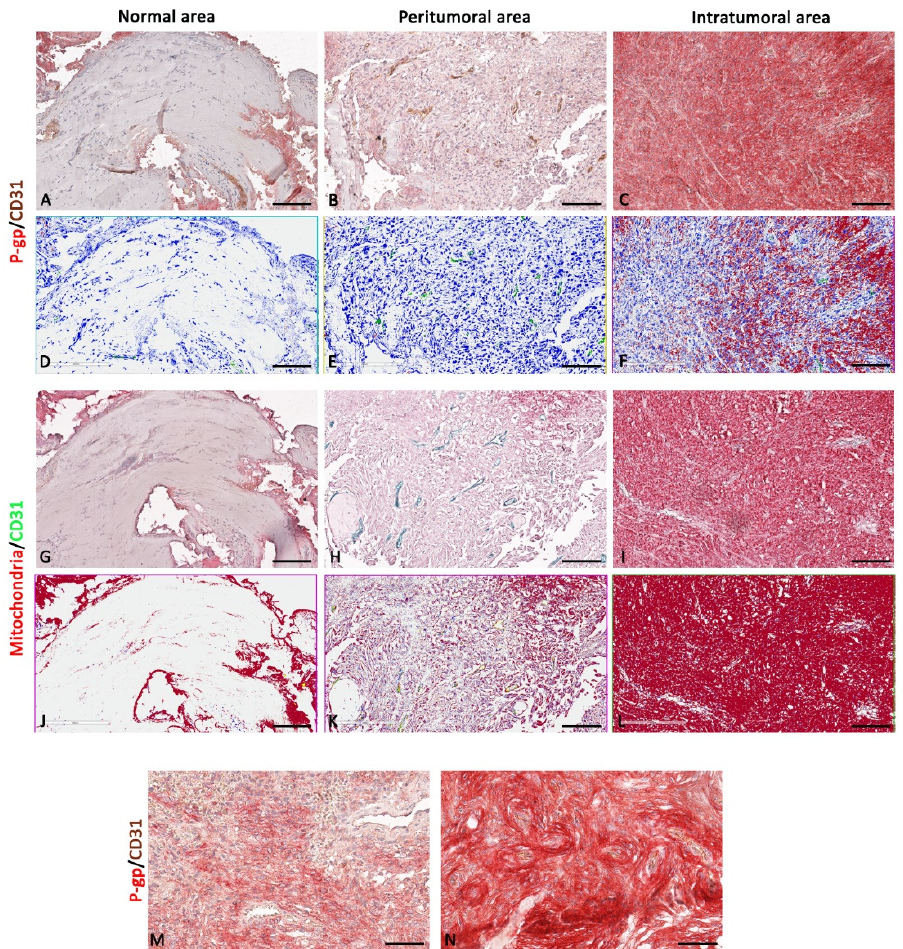
Figure 2. P-gp/CD31 and mitochondria/CD31 expression and colocalization in meningioma. P-gp, mitochondria, and CD31 were evaluated by immunohistochemistry within the same spatial ROIs on meningioma serial sections. P-gp ( A – F ) and mitochondria ( G – L ) expression progressively increase from normal to intratumoral areas. CD31 expression is reduced in the intratumoral areas compared with peritumoral and normal ones ( A – L ). Intratumoral areas show vascular co-option ( M , N ). Scale bar: ( A – L ) 100 µ m; ( M , N ) 30 µ m. Below each micrograph is the relative markup image generated by the Aperio colocalization